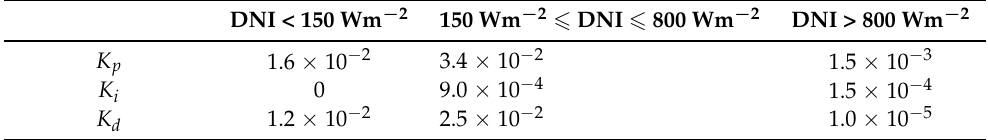
Table 2. Optimized gains of the adaptive PID